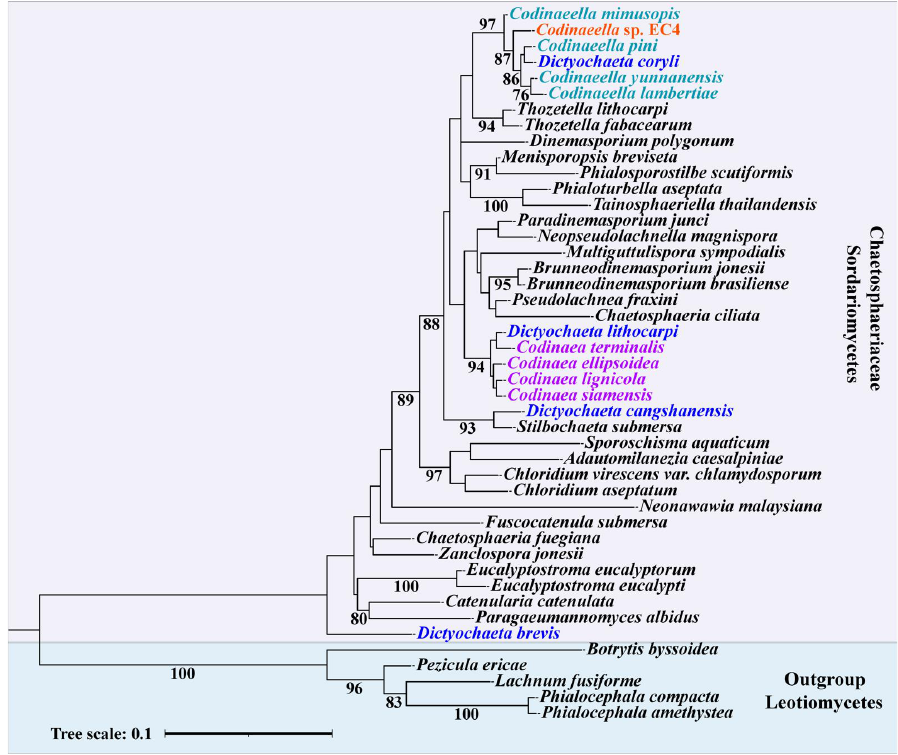
Figure 3. Phylogenetic placement of EC4. The phylogeny is based on 28S rRNA sequences of Chaetospheriaceae and Leotiomycetes (outgroup) available from the NCBI RefSeq Targeted Gene Loci Project [PRJNA51803]. The accession numbers of the species used are listed in Supplementary Table S4. The tree was inferred with RAxML [51] using the GTRCAT model. Only bootstrap support values ≥ 75 are shown. EC4 groups together with the taxa of the Codinaeella genus, with a support value of